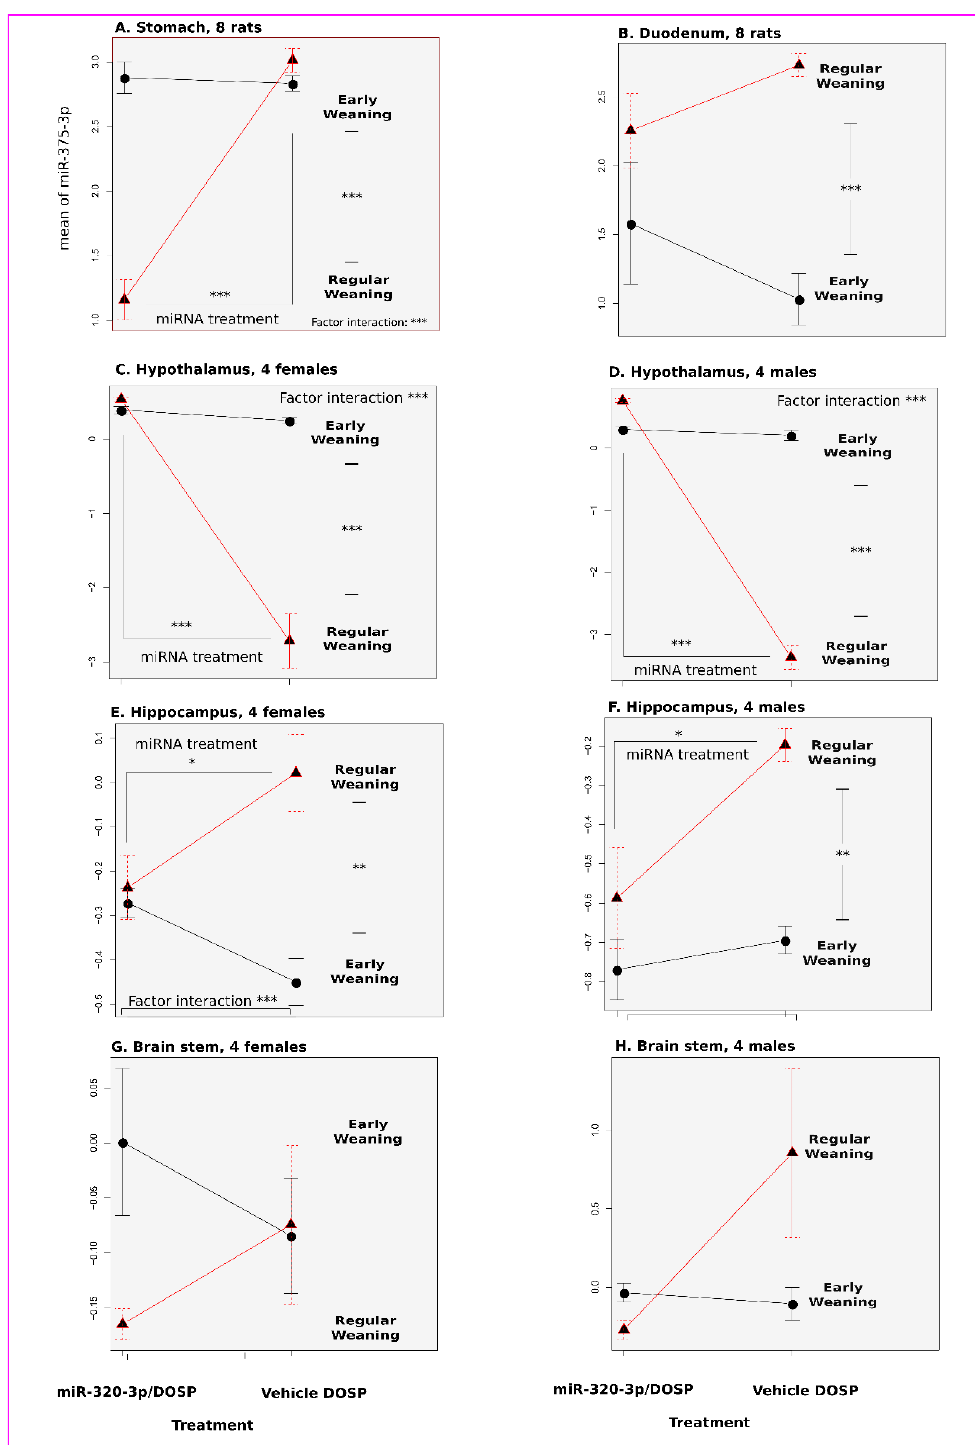
Figure 3. Long-term effects of miR-320-3p/DOSP treatment on miR-375-3p expression. The plot of means shows the expression of miR-375-3p in tissue extracts of the stomach ( A ), duodenum ( B ), hypothalamus ( C , D ), hippocampus ( E , F ), and brain stem ( G , H ). The miR-375-3p levels in brain stem extracts of female and male rats were strikingly different. A strong effect was found in the stomach but not in the duodenum. The light gray background indicates that rats were sacrificed in the dark phase. Note that the lines joining the points underline the direction of the variations, they are not curves of variations. * p < 0.05; ** p < 0.01; *** p < 0.001.